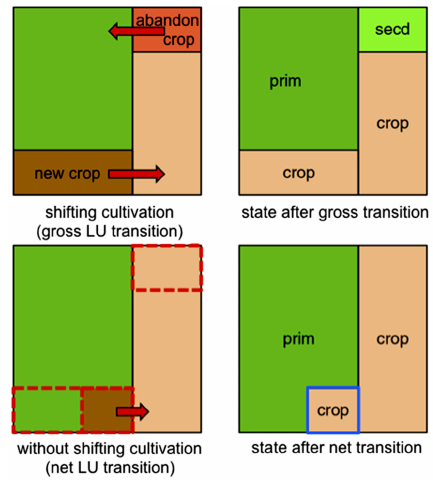
Figure 4. Schematic diagram showing difference between inclu- sion of shifting cultivation (gross transitions) vs. exclusion of shift- ing cultivation (net transitions). Where shifting cultivation is in- cluded (upper row), new cropland (or pastureland) is taken (defor- estation) from primary land (“prim”) and abandoned to secondary land (“secd”) in parallel within a grid cell. In this case carbon fluxes, for example, are captured for each transition. Where shifting culti- vation is not represented (lower row), only the difference of new cropland minus abandoned cropland (represented by crop area out- lined in blue in bottom right figure) undergoes a transition to crop- land and no cropland is abandoned to form secondary land. In this case, a smaller grid cell area fraction is affected by LUC. Adapted from Fig. 1 of Stocker et al.